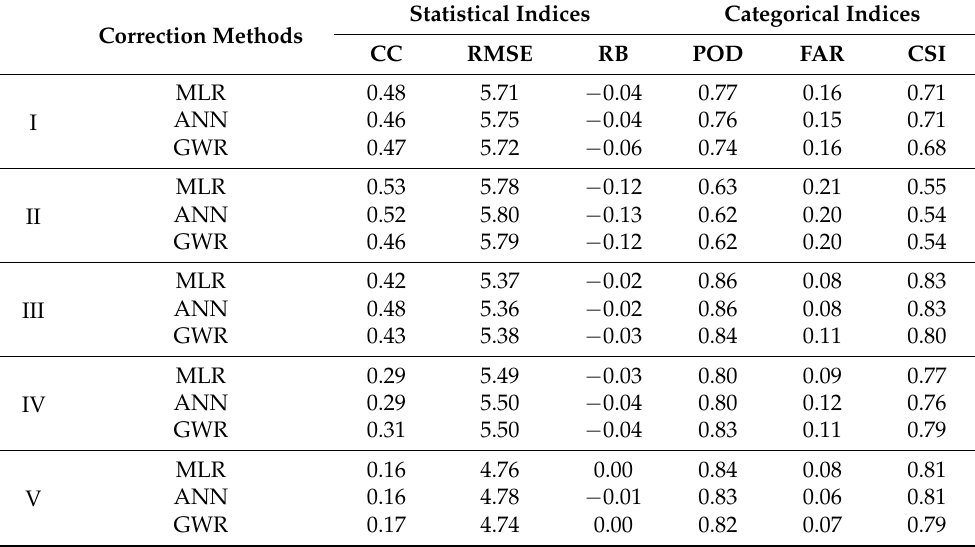
Table 3. Evaluation indices results of correction